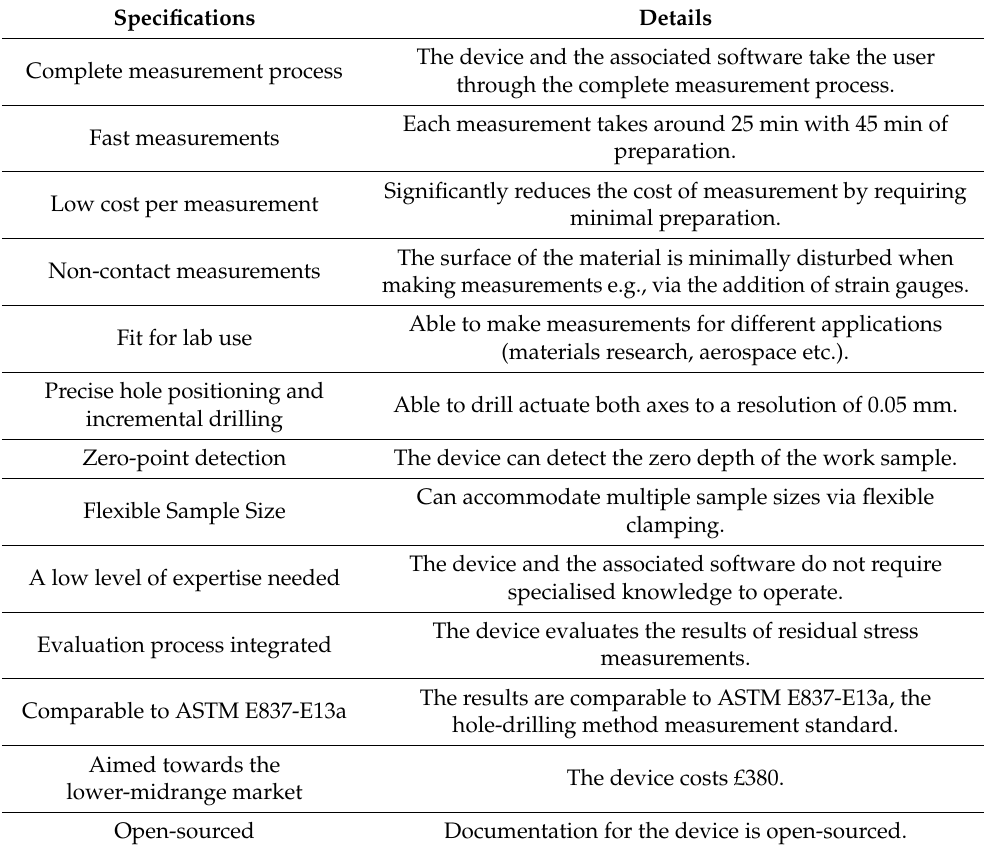
Table 2. Target specification of device offered by the measurement